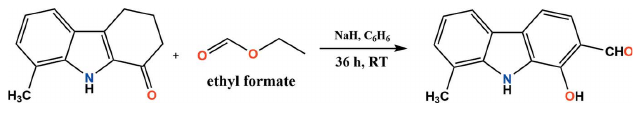
Figure 5 Synthesis of the title compound.